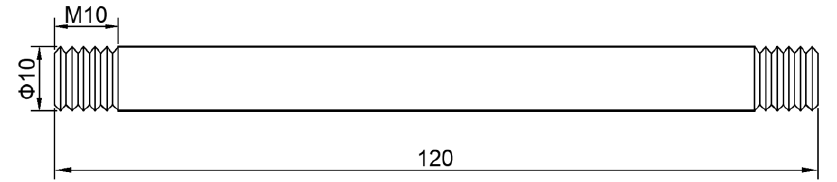
Figure 1. Size of the sample used in the high-temperature tensile test (mm).